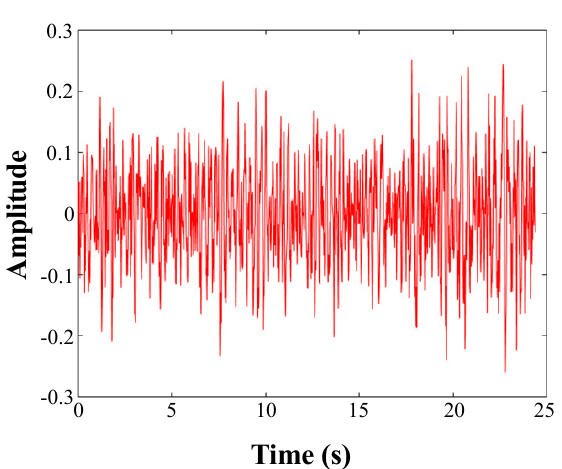
Figure 12. The original signal.